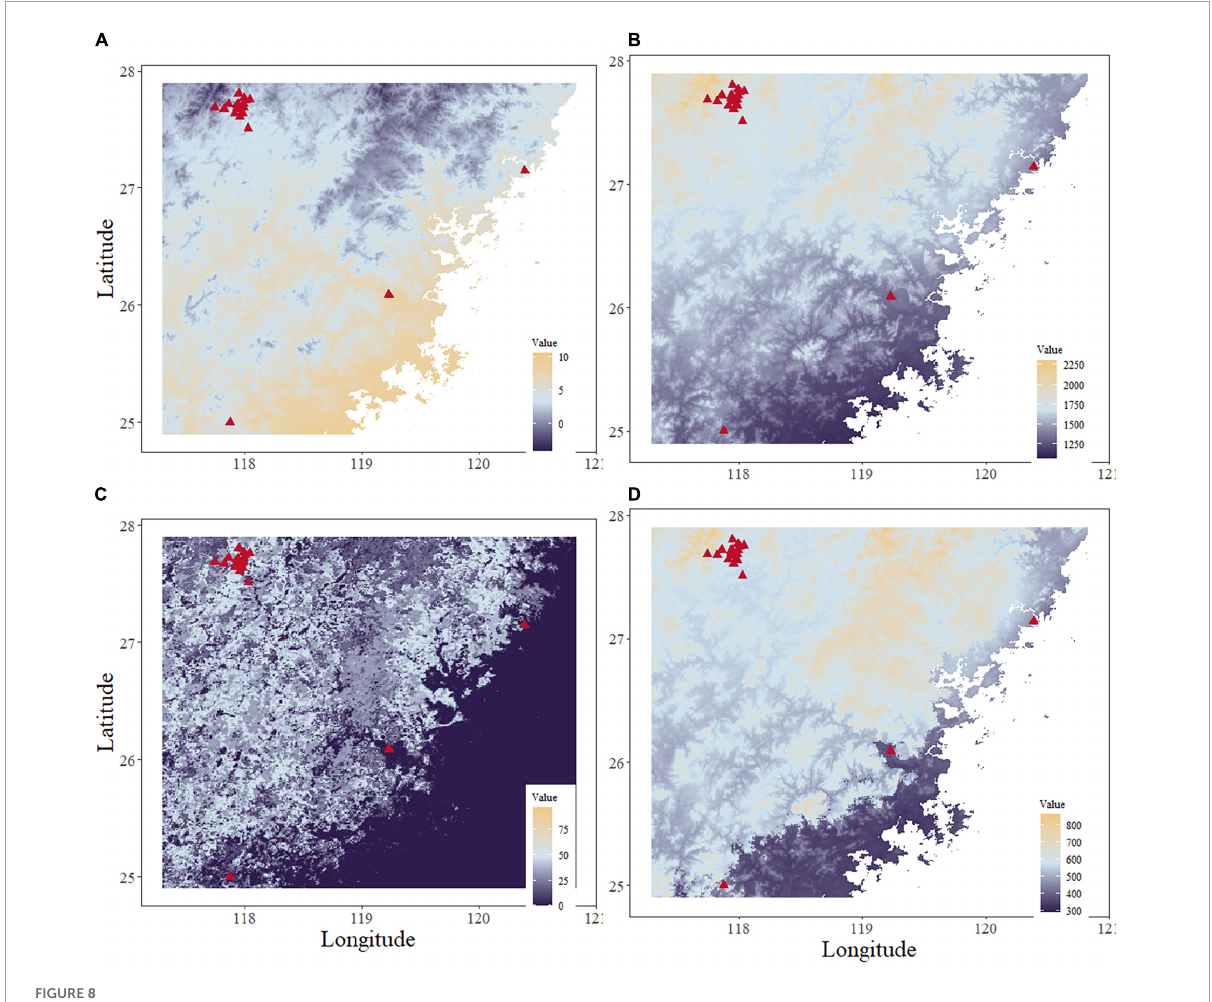
FIGURE8 Maps of the top four environmental variables. (A) Minimum temperature of the coldest month. (B) Annual precipitation. (C) Evergreen/deciduous needleleaf trees. (D) Precipitation in the warmest